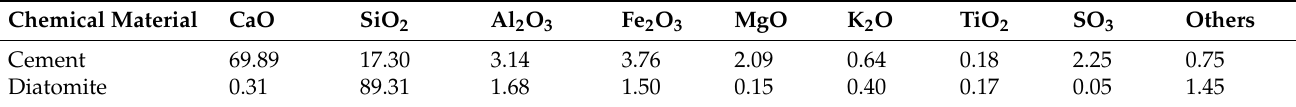
Table 1. Chemical component of cement and diatomite (% by mass).